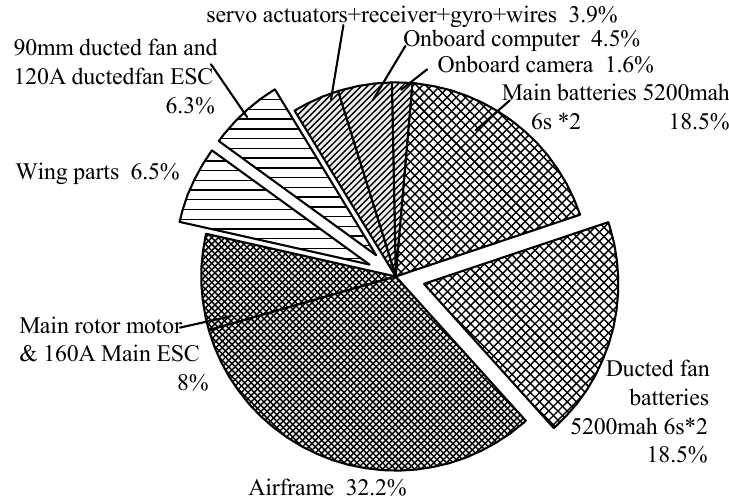
Figure 4. The weight distribution of Configuration WD.